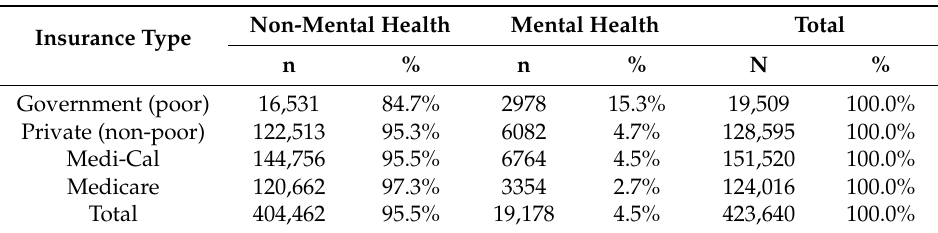
Table 2. Reasons for hospitalization by insurance